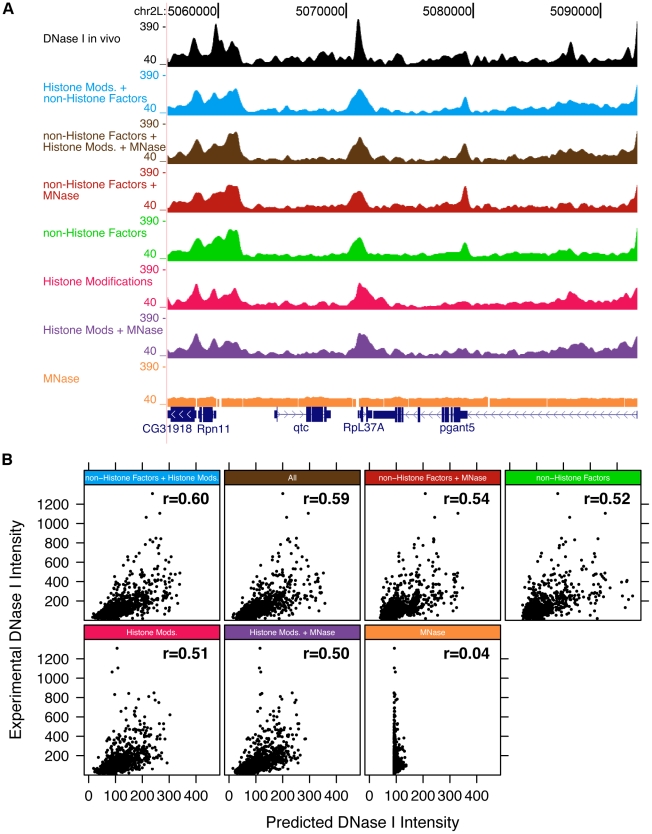
DNase I hypersensitivity can be inferred using histone marks and MNase data.A) The intensity of DNase I hypersensitivity landscape is inferred by models (colors) that use histone modification profiles, non-histone factor profiles, DNase I data and MNase-seq data. B) The experimentally determined DNase I hypersensitivity data is plotted against inferred intensity for the various models. The Pearson correlation for each model is shown.